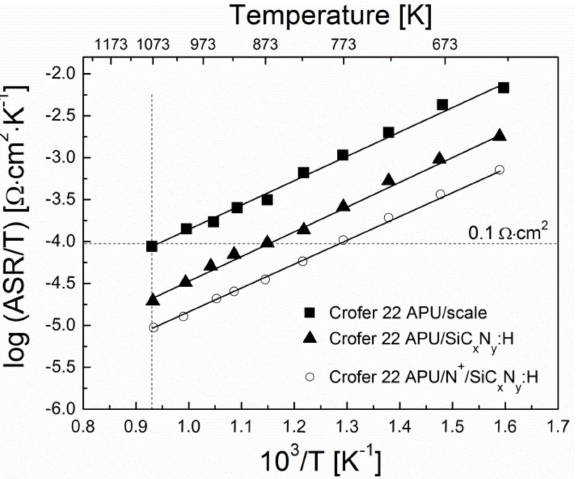
Figure 10. ASR vs. temperature dependency for the unmodified Crofer 22APU steel, steel without N + ion modification and with the deposited layer (SiC x N y :H), and steel after N + ion modification with the deposited layer (N + /SiC x N y :H) after 500 h of oxidation in air, in an Arrhenius